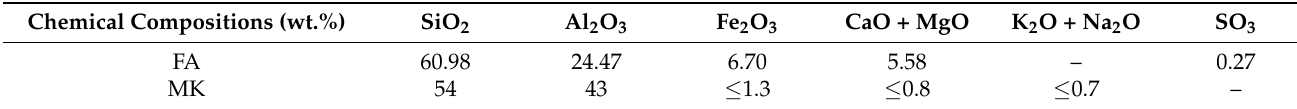
Table 2. Chemical compositions of FA and